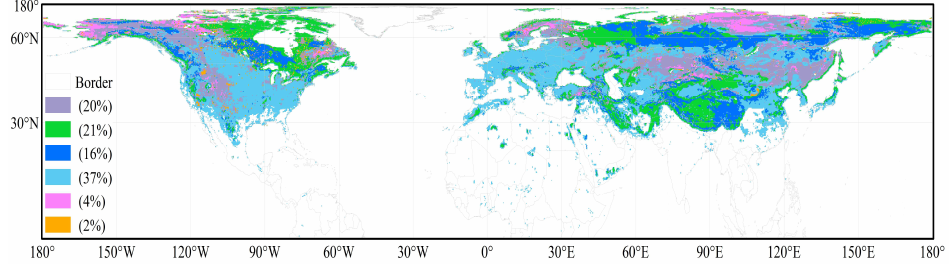
Figure 11. Analysis results of the variation trends for SCD and the annual average SD over the Northern Hemisphere in 1992–2016. Grey indicates that the areas are undergoing a significant increase (or decrease) in SCD (or annual average SD) and non-significant change for annual average SD (or SCD); green indicate that the areas are undergoing a significant decrease in the annual average SD and SCD; blue indicates that the areas are undergoing a significant decrease in the annual average SD and a significant increase in SCD; cyan indicates that the areas are undergoing a non-significant change in the annual average SD and SCD; violet indicates that the areas are undergoing a significant increase in annual average SD and a significant decrease for SCD; orange indicates that the areas are undergoing significant increase in annual average SD and SCD. The significant increase (or decrease) here means that this variation trend passes the 95% confidence level test. The numbers in the brackets represent their proportion of the total snow cover area.